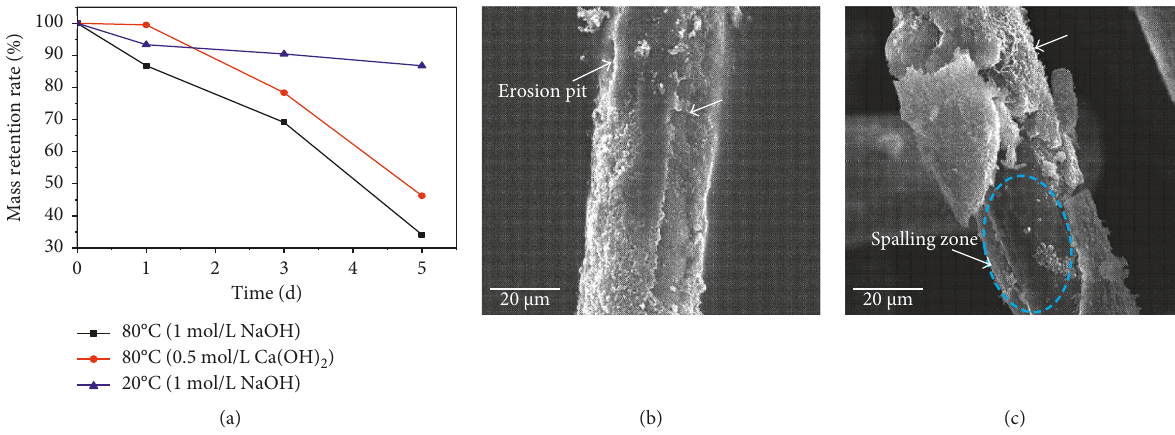
F IGURE 2: The effect of alkali corrosion temperature on BF. (a) The mass retention rate-alkali corrosion time curves at different temperatures and the alkali corrosion damage at (b) 20 ° C and (c) 80 ° C